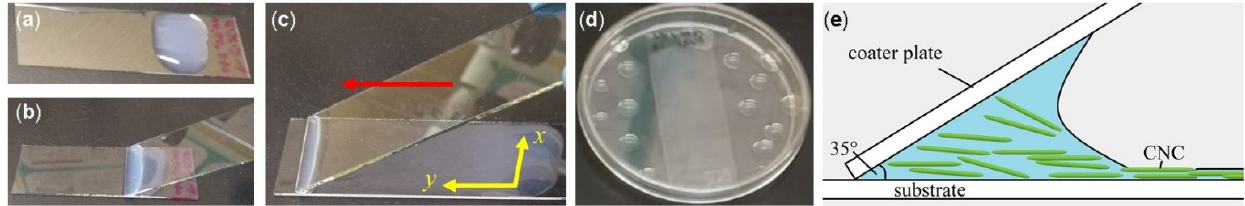
Figure 1. Images of the shear-coating method: ( a ) a drop of CNC suspension is placed on a glass substrate; ( b ) another slide, the coater plate, is placed so that the suspension adheres to it; ( c ) the coater plate is moved to the opposite side of the substrate to distribute the suspension; ( d ) the sample is left inside a Petri dish so that the suspension slowly evaporates in a humid environment. ( e ) Schematics of the deposition of CNC during film deposition.